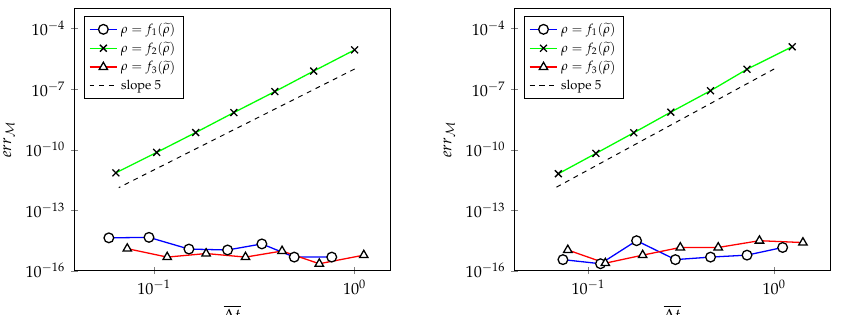
Figure 3. Sine density wave advection—mass conservation analysis for each choice of the change of density variable at density ratio r ρ = 2 using the implicit ESDIRK5(8) scheme. DG polynomial approximation of degree k = 1 ( left ) and k = 6 ( right ) on a uniform mesh of 10 × 1 square elements.